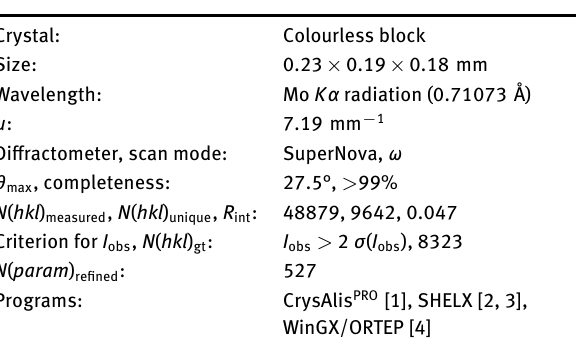
Table 1: Data collection and handling.